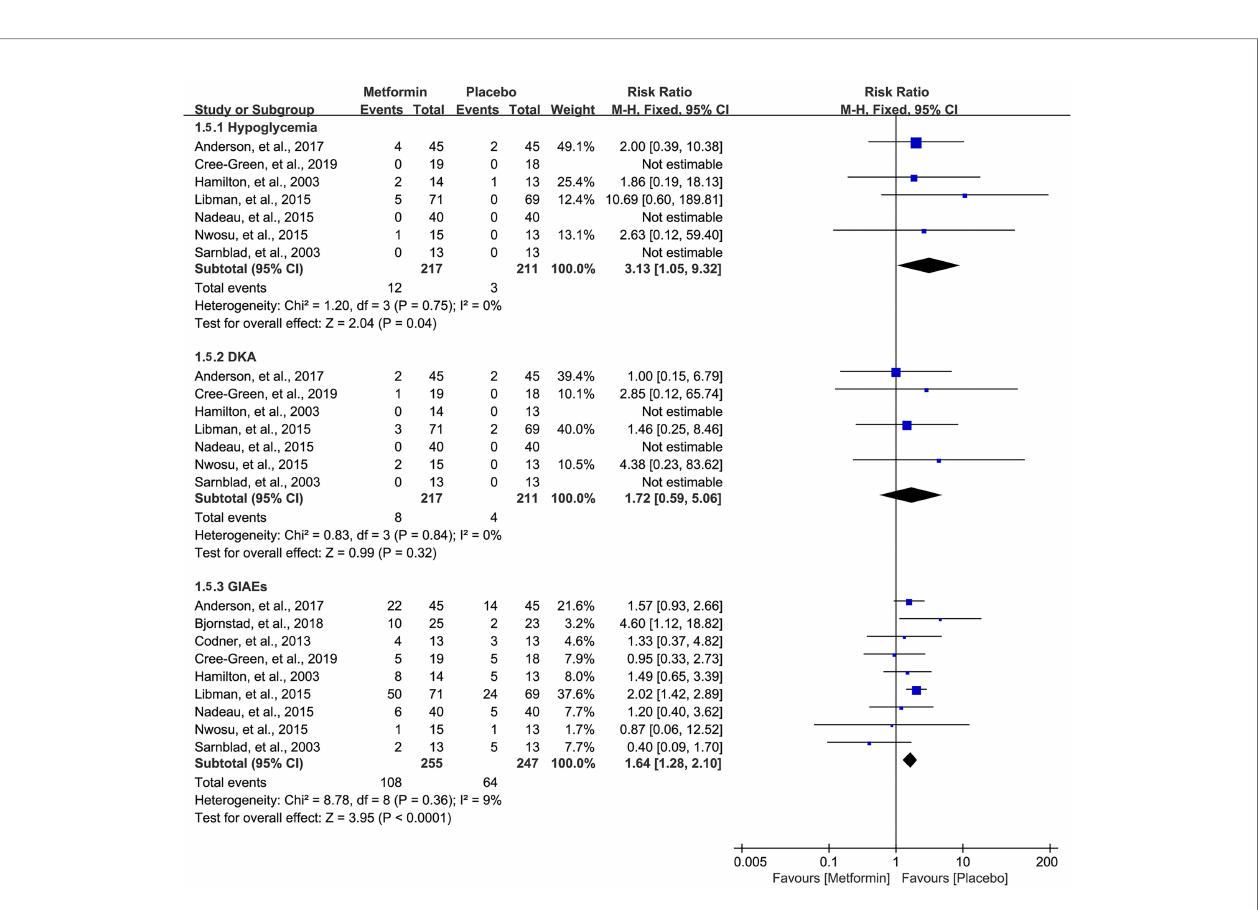
Frontiers in Endocrinology |